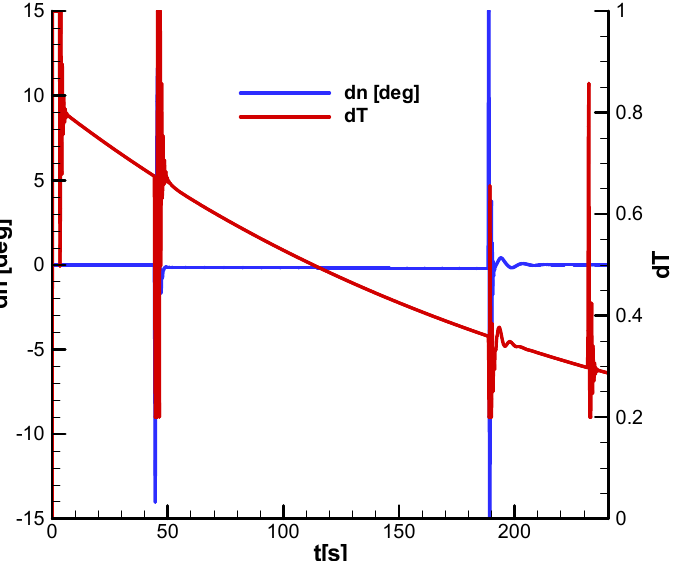
Figure 24. Diagram of longitudinal commands dT —thrust throttling command; dn —pitch deflection command.